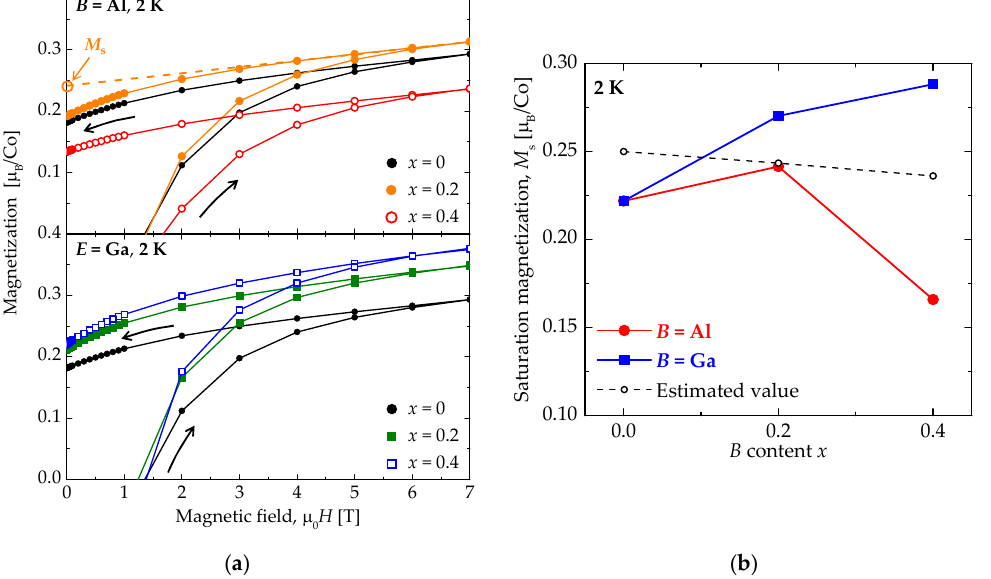
Figure 4. ( a ) Magnetic field dependence of the magnetization of Sr 3.1 Y 0.9 Co 4− x B x O 10.5 ( B = Al and Ga: x = 0, 0.2, and 0.4) at 2 K. ( b ) Saturation magnetization M s of Sr 3.1 Y 0.9 Co 4− x B x O 10.5 as a function of the E content x .